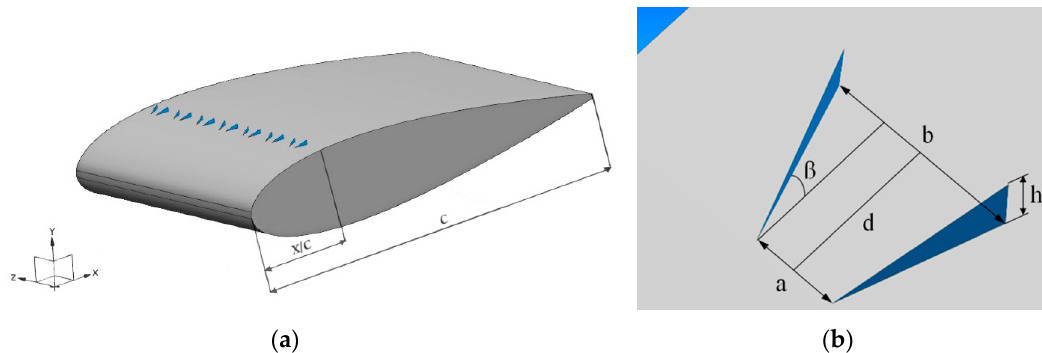
Figure 4. Cells corresponding to the VG device where body forces are applied: ( a ) top view and ( b ) side view.